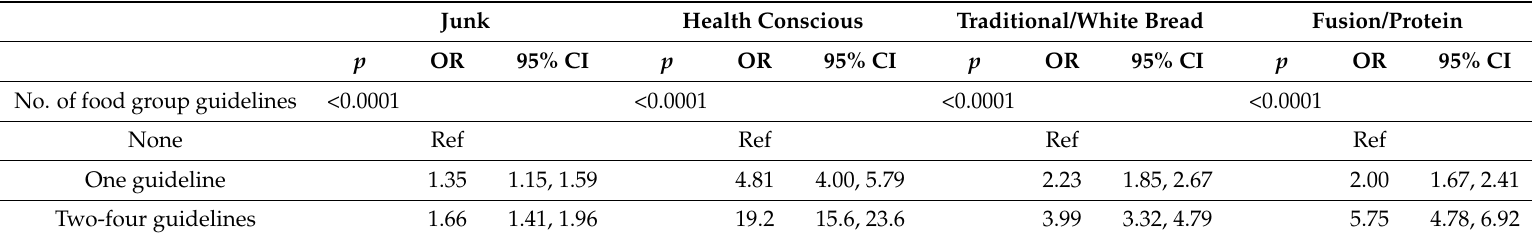
Table 4. Associations of each maternal dietary pattern with the number of food group guidelines for which adherence was present, adjusting for all maternal socio-demographic, health and lifestyle factors 1 (Odds ratios (OR) and 95% confidence intervals (CI)).